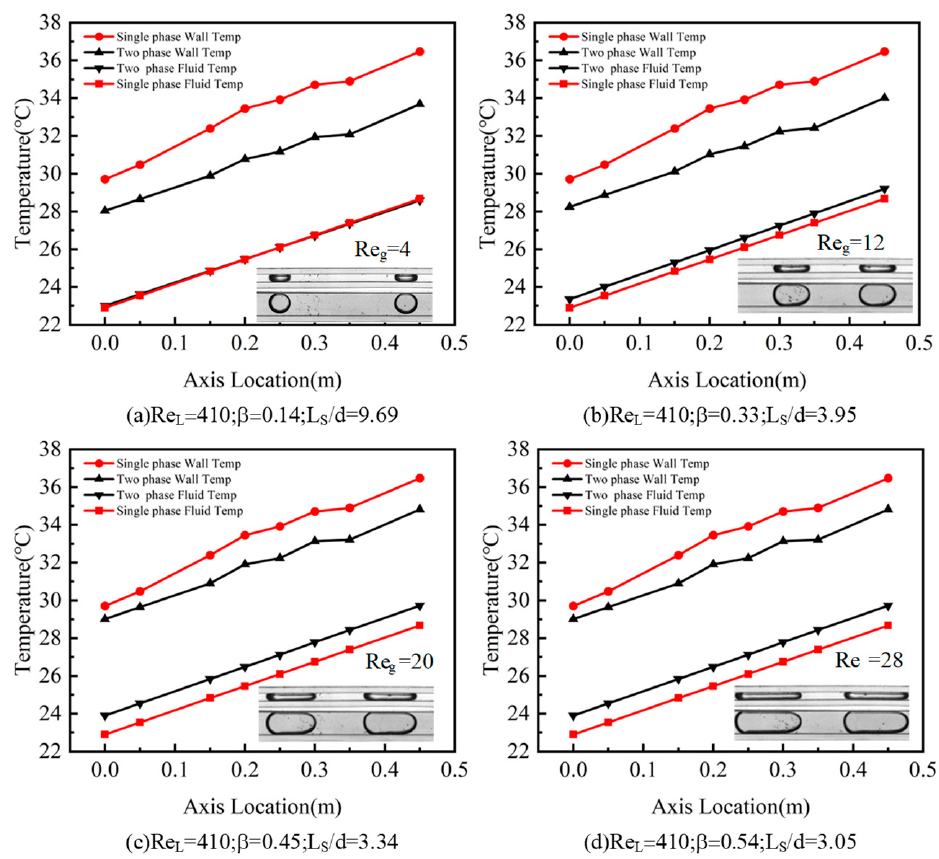
Figure 6. Wall and fluid temperature variations in the rectangular channel in the axial direction: ( a ) Reg = 4; ( b ) Reg = 12; ( c ) Reg = 20; ( d ) Reg = 28.